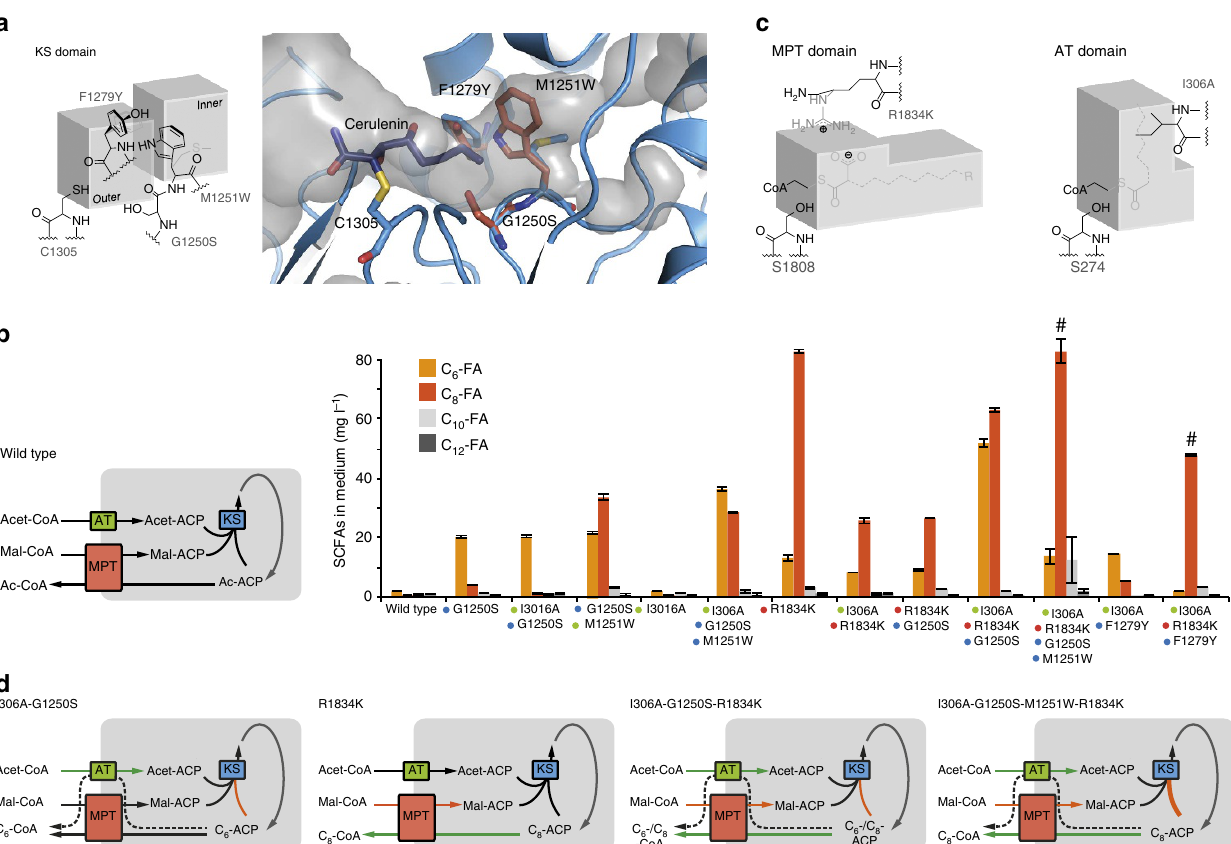
Figure 2 | Active site engineering of S. cerevisiae FAS. ( a ) KS active site mutated in three positions. (Right panel) X-ray structural data of KS with the binding channel in its open state (structure coloured in blue; PDB code 2VKZ (ref. 19)). Cerulenin, a FAS inhibitor and acyl mimic, which induces binding channel opening, is shown in dark blue. A structural model of G1250S-M1251W-F1279Y-mutated KS in its closed state is superimposed (residues shown in orange). (Left panel) Abstracted KS active site indicating an outer and an inner volume of the acyl binding channel, gated by methionine (native) or tryptophan (mutated FAS), respectively. Amino acids in grey show wild-type KS in its open-state conformation. Bound substrates are omitted for clarity. The closed-state conformation is shown for G1250S-M1251W-F1279Y-mutated KS (residues in black). ( b ) SCFA product spectra of selected mutated FAS strains in YPD medium. Error bars reflect the standard deviation from three technical replicates (collected on one biological sample). Biological repeatability is shown in Supplementary Fig. 1 and Supplementary Table 1. Please note, while b shows values from one biological sample, values in the text refer to means of two values (Supplementary Table 1). Mutations in KS are indicated by blue dots, and mutations in transferase domains MPT and AT by dots in red and green, respectively. Strains with I306A-R1834K-G1250S-M11251W-mutated FAS and I306A-R1834K-F1279Y-mutated FAS (both marked by #) grew only to approximately one-third of the regular cell density as compared to the other strains. A scheme on FAS-mediated FA synthesis is attached (flux scheme). Just enzymatic domains are shown that have been mutated in our approach (see for comparison Fig. 1b). ( c ) Cartoon representation of ATand MPT active sites. For MPT, the wild-type arginine is shown in grey. Bimodal binding is indicated by substrates with solid and dashed lines; acyl-CoA in dashed lines overlaid with malonyl-CoA in solid lines for MPT, and C 8 -CoA (dashed) overlaid with acetyl-CoA (solid) for AT. ( d ) Flux schemes of engineered FASs estimated from data reported in literature, as well as deduced from the extracellular SCFA distribution. Red arrows indicate reduced and green arrows increased fluxes compared to wild type ( b ). A dashed line indicates a putatively new reaction channel installed by engineering. Flux schemes do not explain relative C 6 -/C 8 -FA